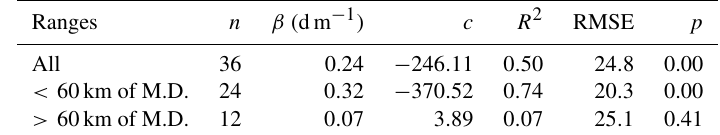
Table 3. Robust (bi-square) regression parameters between mean elevation and mean SCD for mountain ranges within the Clutha Catchment. Regression was carried out for all ranges together, and for those ranges within 60km of the Main Divide and those more than 60km from the Main Divide.